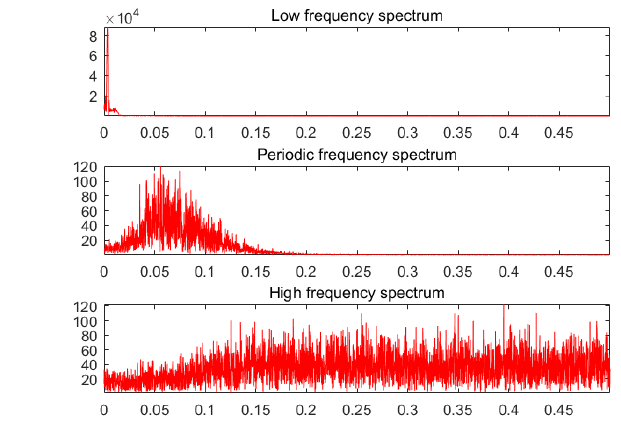
Figure 9. Reconstructed signal and spectrum for Line 3.